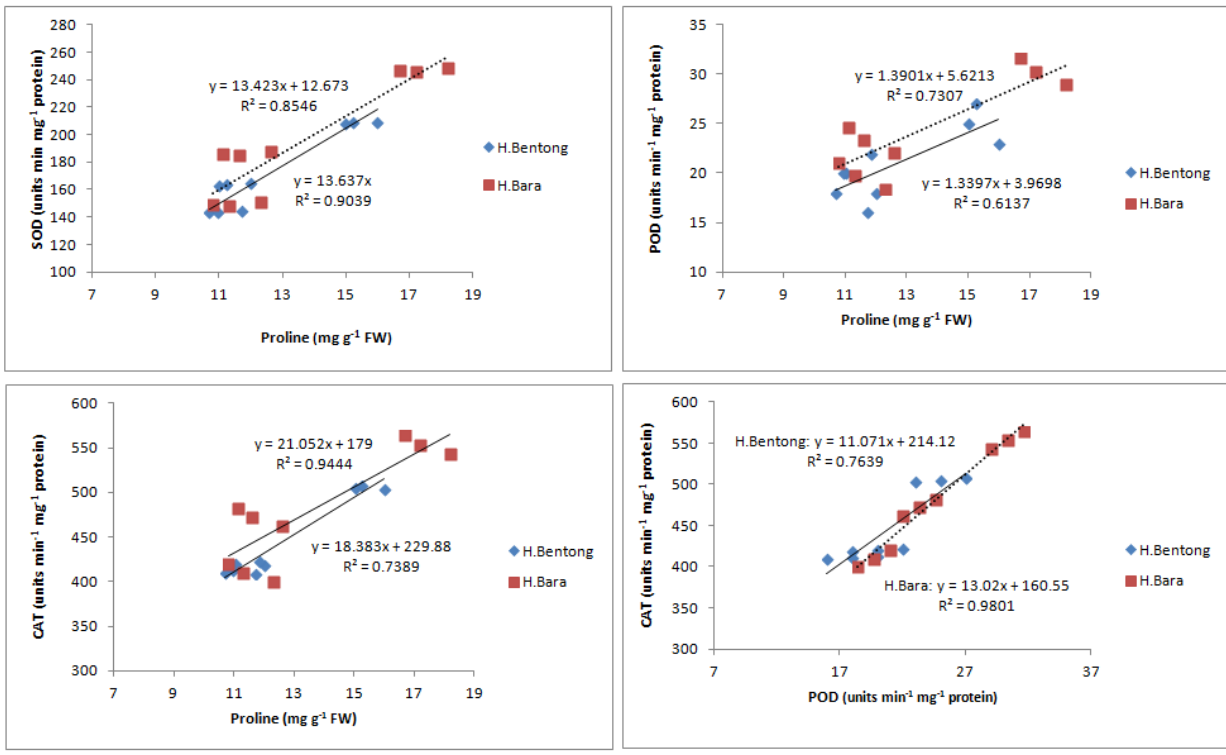
Figure 8. Correlations between proline content and superoxide dismutase (SOD), catalase (CAT) and peroxidase (POD) activities. * P < 0.05; ** P <